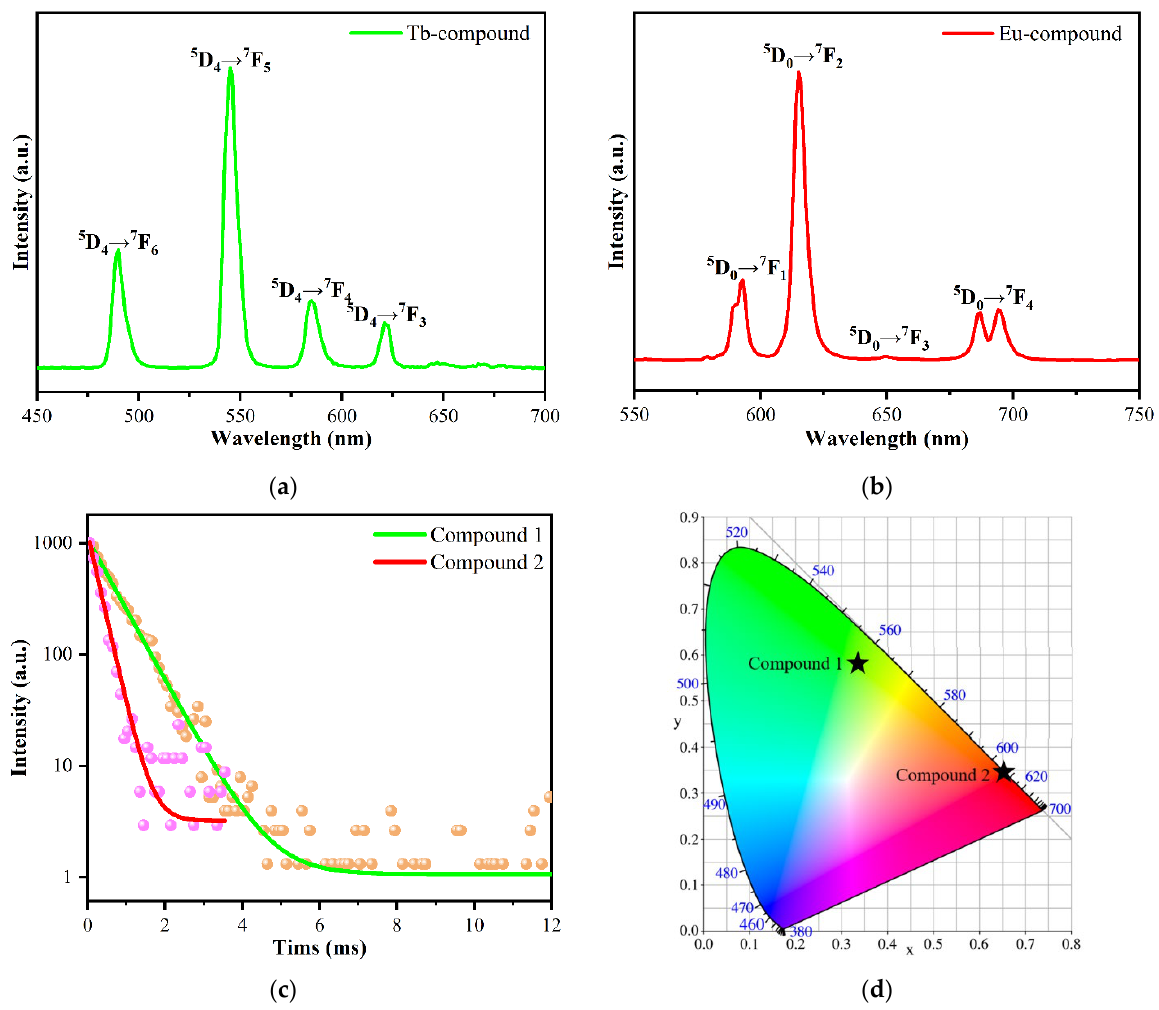
Figure 4. Photophysical profiles of the compounds 1 and 2 : ( a ) emission spectrum of the compound 1; ( b ) emission spectrum of the compound 2 ; ( c ) luminescence decay curves for the compounds 1 and 2 ; ( d ) CIE 1931 diagram for the emission of the compounds 1 and 2 (points corresponding to emission colors are indicated by stars).